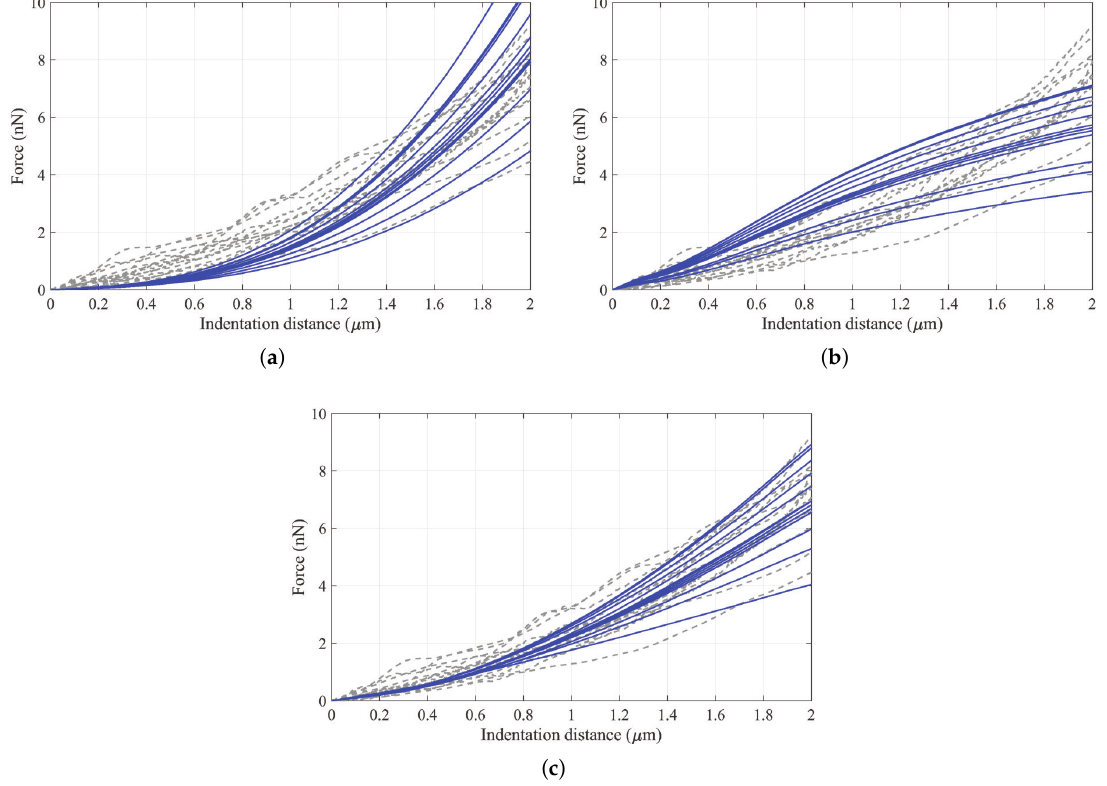
Figure 11. The highest R 2 results provided by the ( a ) hyperelastic model ( b ) ten-level tensegrity model ( c ) integrated model; The dash lines are the experimental F-D curves, and the solid lines are corresponding computational F-D curves with the best